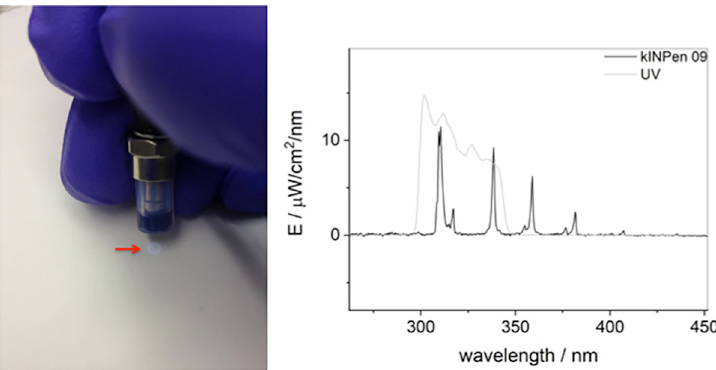
Fig 2. UV source. Xe flashlight with a power supply (Voltcraft Conrad Electronic, Wollerau, Switzerland) was used as UV source. Left: Visible UV emission at the end of the distance spacer (arrow). Right: Comparison of the UV spectrum of the kINPen09 (bold line spectrum) and the UV source (fine continuous